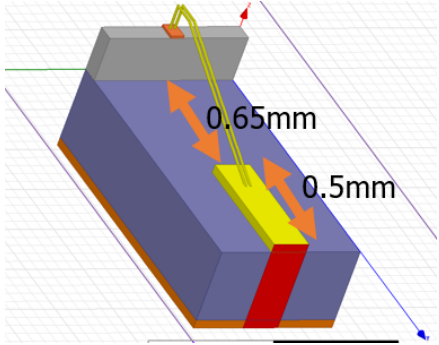
Figure 26. 3D modeled double bond